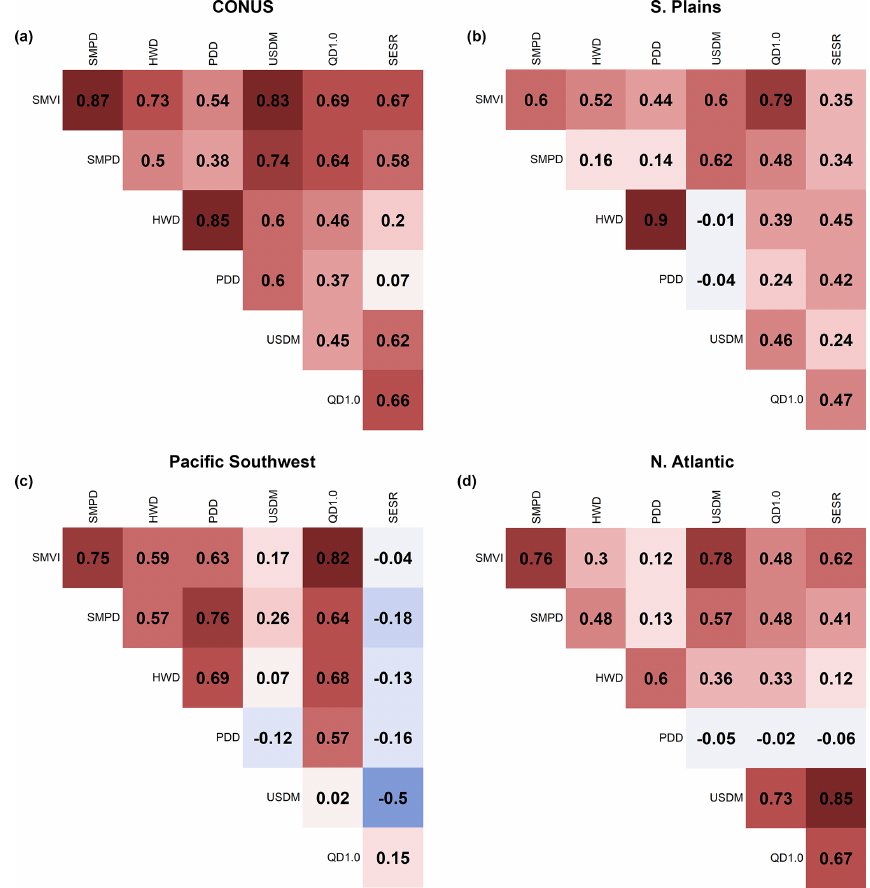
Figure 5. Pearson’s correlation coefficient matrix for the different definitions’ percentage of area hit by flash droughts over the Bukovsky regions: (a) CONUS, (b) Southern Plains, (c) Pacific Southwest, and (d) North